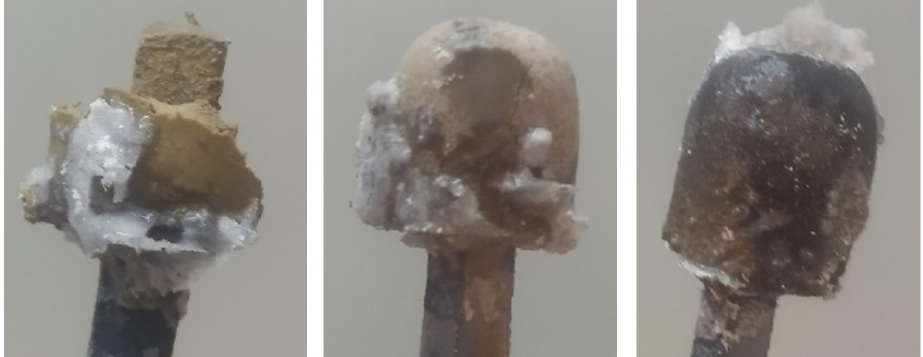
Figure 3. Photographs of the cathode deposits obtained after the electrolysis of the KCl–K 2 SiF 6 –SiO 2 melt at a temperature of 790 ° С and cathode overvoltage of 0.25, 0.15, and 0.1 V vs. QRE potential.